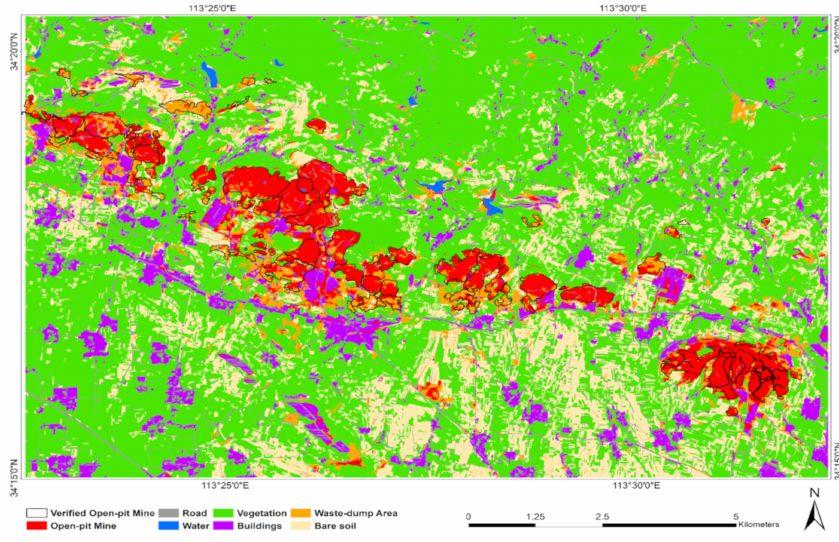
Figure 11. Results of SVM-based open-pit mine mapping.